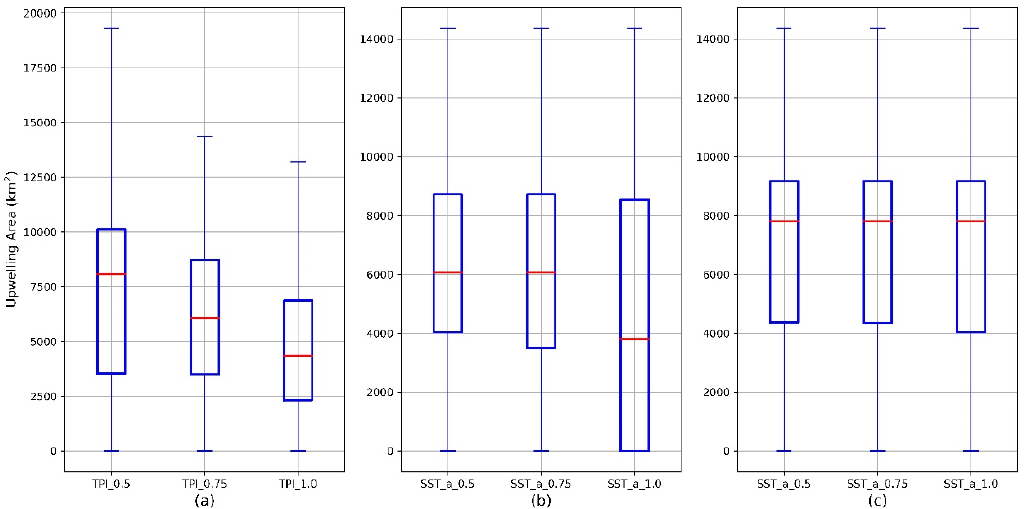
Figure 4. The summarized results of the sensitivity analyses of the Qiongdong coastal upwelling mapping in 2016 to the Φ and Ψ values, displayed as boxplots. ( a ) Ψ = 0.75 ◦ C, Φ varies in (0.5, 0.75, 1.0), n = 92; ( b ) Φ = 0.75, Ψ varies in (0.5 ◦ C, 0.75 ◦ C, 1.0 ◦ C), n = 92; ( c ) Φ = 0.75, Ψ varies in (0.5 ◦ C, 0.75 ◦ C, 1.0 ◦ C), n = 60. The blue box indicates the range between the first (25th percentile) and the third (75th percentile) quantiles. The solid red line indicates the median. The two caps indicate the data